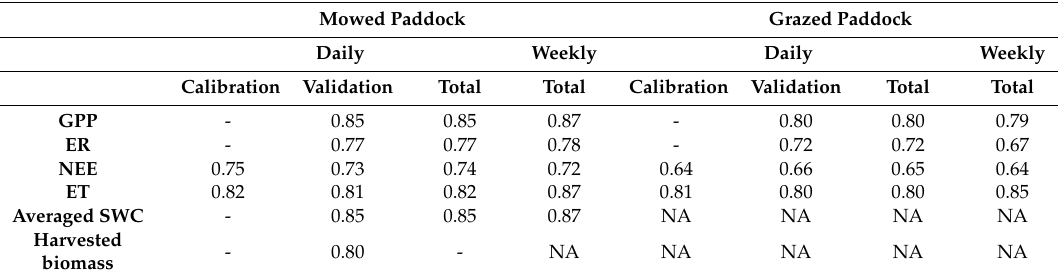
Table 1. Model e ffi ciencies for six key observations of the two-modeled systems. Only daily NEE and ET were used for the model parameterization. ‘Total’ refers to the complete data set that included data in both the parameterization and validation data